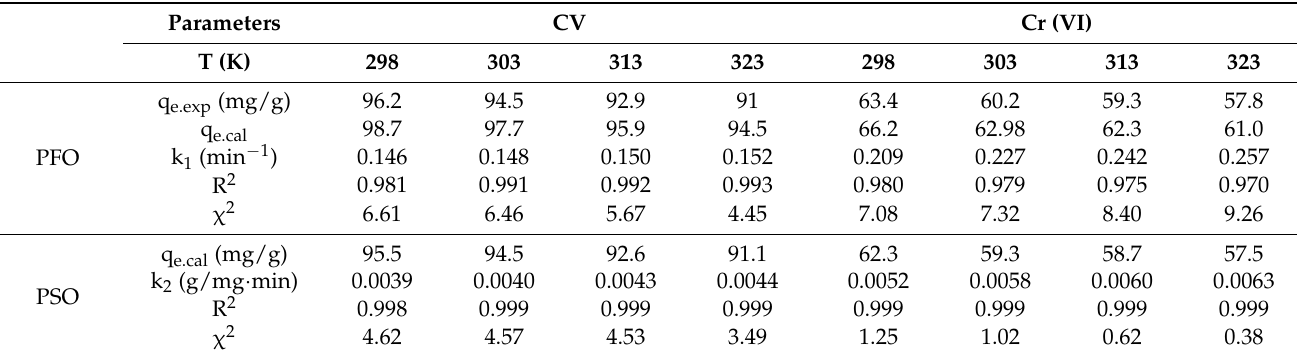
Figure 11. Plots of the PPO and PSO models at different temperatures. Table 4. Adsorption rate constants of PFO and PSO.